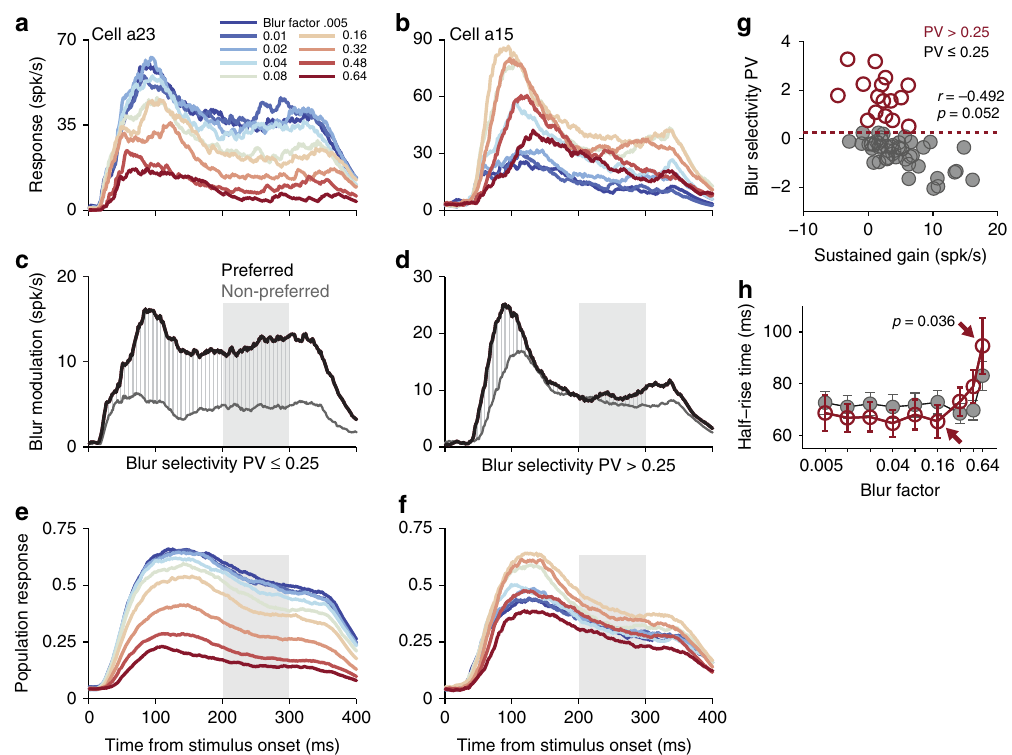
Fig. 8 Response dynamics differ with respect to blur selectivity. a , b PSTH of preferred stimuli for low (blue) to high (red) blur factors for sharp-selective and blur-selective cells. a For the sharp-selective cell, increasing blur decreases neuronal response throughout the stimulus presentation interval. b For the blur-selective cell, blur modulation is transient. c , d Blur modulation ( y -axis), calculated as the s.d. of responses with respect to blur, for preferred and non- preferred shape stimuli from example cells in a and b . The difference between the blur modulation timecourse (hatching) of preferred and non-preferred shapes captures the period in time at which blur multiplicatively scales shape-selective responses. e , f Average normalized PSTHs demonstrating distinct response dynamics between these cell groups. g The principle value of blur selectivity (Fig. 2e) plotted as a function of the average difference in blur modulation between preferred and non-preferred shape stimuli across the sustained period (200 – 300 ms; shaded region of e , f ). h For each blur factor, mean latency to half-of-maximum response (half-rise time) for each cell group. Error bars denote s.e.m. A signi fi cant increase in response latency ( t -test, p = 0.036) occurs across cells selective for intermediate blur (PV 0.25) between blur factors 0.16 and 0.64